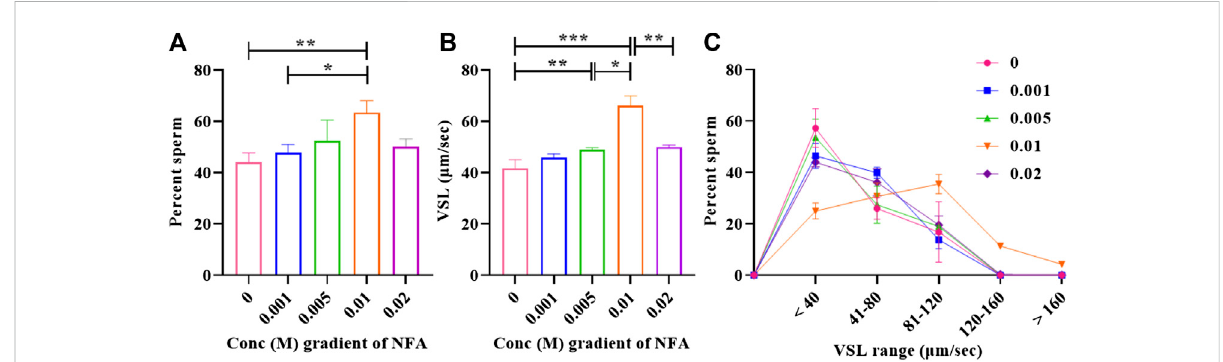
FIGURE 1 Bell-shaped dose-response of sperm to NFA. Chemotaxis was studied using the micro fl uidics device at gradient concentrations of 0, 0.001, 0.005, 0.01, and 0.02 M NFA after capacitating sperm for 2.5 h. Sperm directionality is represented as the percentage of sperm entering the transverse channel and moving toward the ascending concentration gradient of NFA (A) , sperm VSL (B) , and frequency distribution of sperm VSL in response to increasing gradients of NFA (C) . Each column represents mean ± SEM for the respective gradient tested (***p < 0.005; **p < 0.01; *p < 0.05). The results presented are cumulative from three independent experiments.